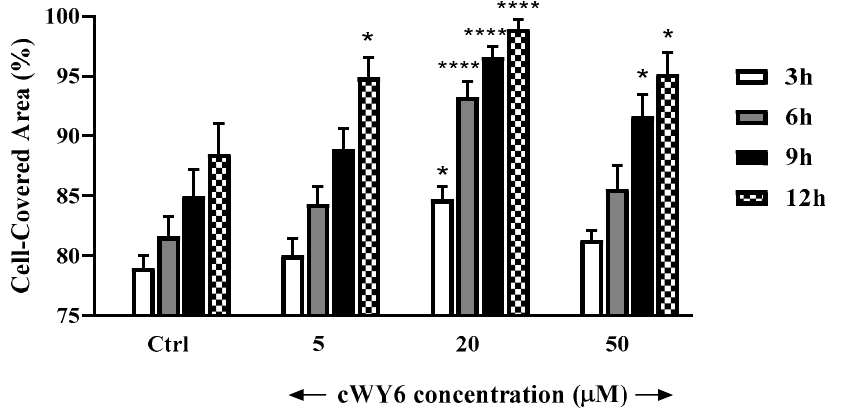
Figure 8. In vitro pseudo-wound-healing effect of cWY6 peptide at different concentrations on HaCaT cells. The percentage of cell-covered area at each time point is reported on the y -axis. Control (Ctrl) is given by vehicle-treated cells. All data are the mean of three independent experiments ± standard error of the mean (SEM). The levels of statistical significance between Ctrl and peptide-treated samples are indicated as follows: * p < 0.05 and **** p < 0.0001.